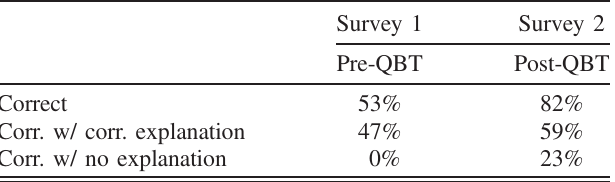
TABLE V. Percentage of students answering that changing the state to the x basis does not create a new quantum state (Q3 in Fig. 5). Pretest and post-test results are shown with 17 matched students accounting for 68% of enrolled